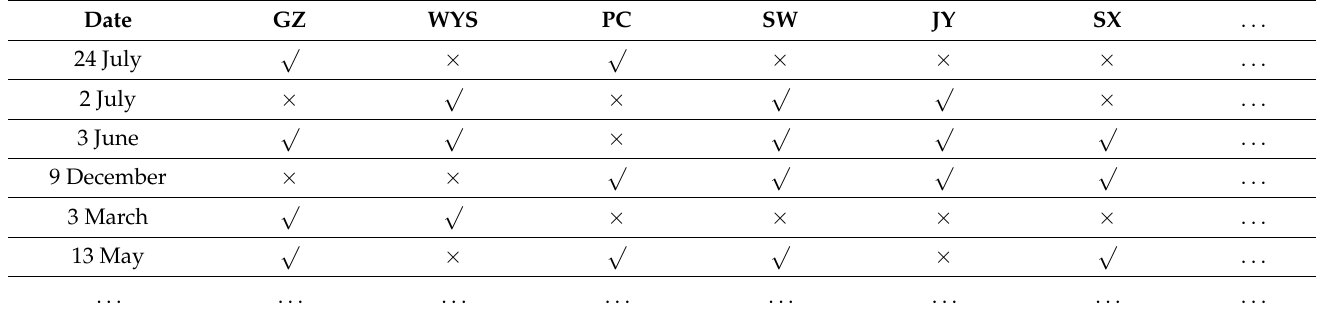
Table 2. Missing data of multi-source line loss rate after deletion operation.